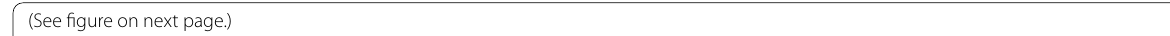
Fig. 2 RECIST 1.1 baseline selection accepted variability and errors. TL: Target Lesions are measured by double arrows, NTL: Non‑Target Lesions are circled. This patient had a disease limited to the liver. We illustrate 3 different types of baseline lesion selection that can be considered as errors and that deviate from RECIST guidance: a if no NTL have been selected; b if the smallest Target Lesions have been selected instead of the largest; c if only 1 TL has been selected while 2 were measurable. We illustrate 3 different lesion poolings that can be considered as variations from the ideal selection without deviating from the RECIST guidelines: d if NTL lesions are grouped inside an organ; e if different TL are chosen within the largest lesions; f if fewer NTL are selected considering the evaluation as categorial and qualitative even though, preferably, they should all be recorded